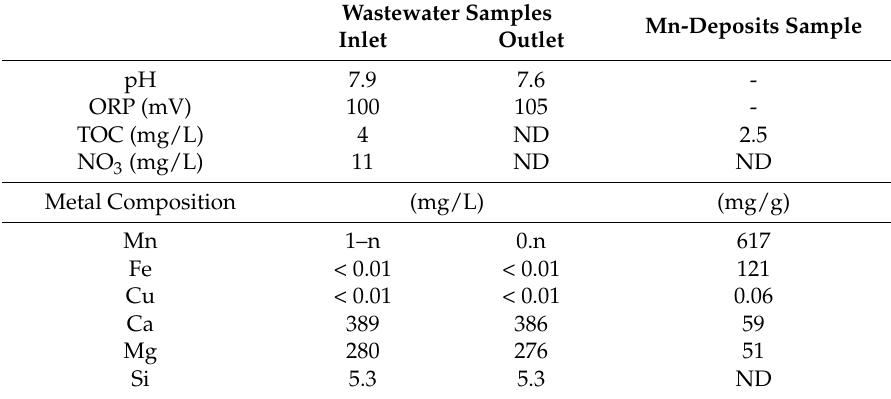
Table 1. Characteristics of wastewater samples (taken from the inlet and outlet of the wastewater